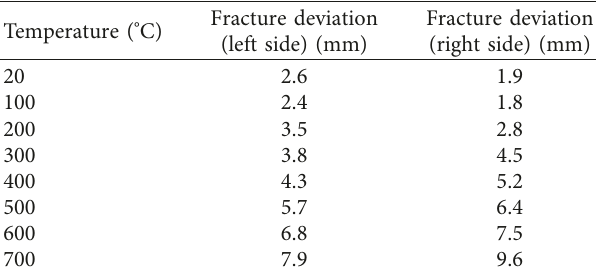
Figure 7: The average of fracture deviation of sandstone at different Table 3: The average of fracture deviation from center line of sandstone at various temperatures.